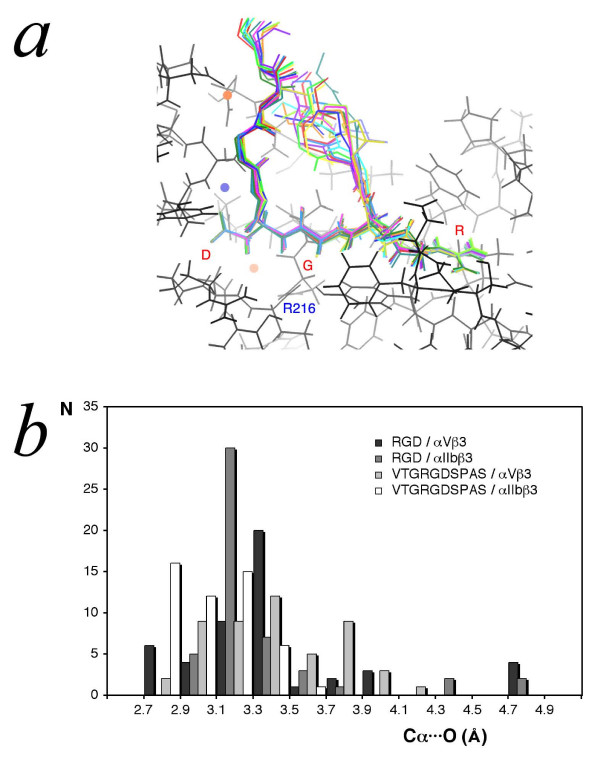
Results of molecular dynamics simulations of docking fibronectin RGD-containing peptides on to models of integrin surfaces. (a) Representation of the 15 lowest-energy models for the docking of the VTGRGDSPAS peptide on αIIbβ3 model surface. Integrin residues are shown in black whereas the 15 peptide models are shown in different colours. For peptide models, the only side chains shown are those from the RGD triad (indicated with red labels). In all models the central Gly residue in the RGD triad is located directly on top of the carbonyl group from Arg 216 in the β3 subunit (shown with blue label). (b) Distribution of Cα···O distances in the final models of the molecular dynamics simulations Distances computed between the carbonyl oxygen in Arg216 from the β3 subunit and the central Gly residue from the RGD triad.